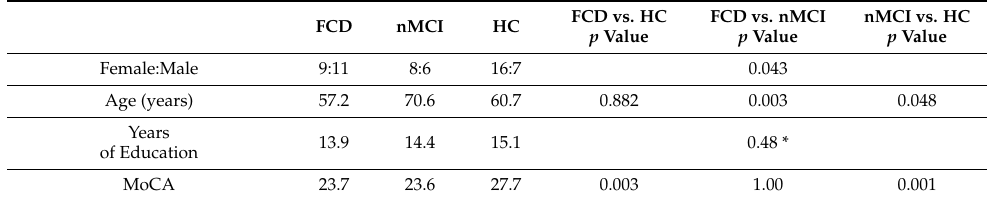
Table 1. Group demographics and cognitive functioning (mean values; significant p values in bold).